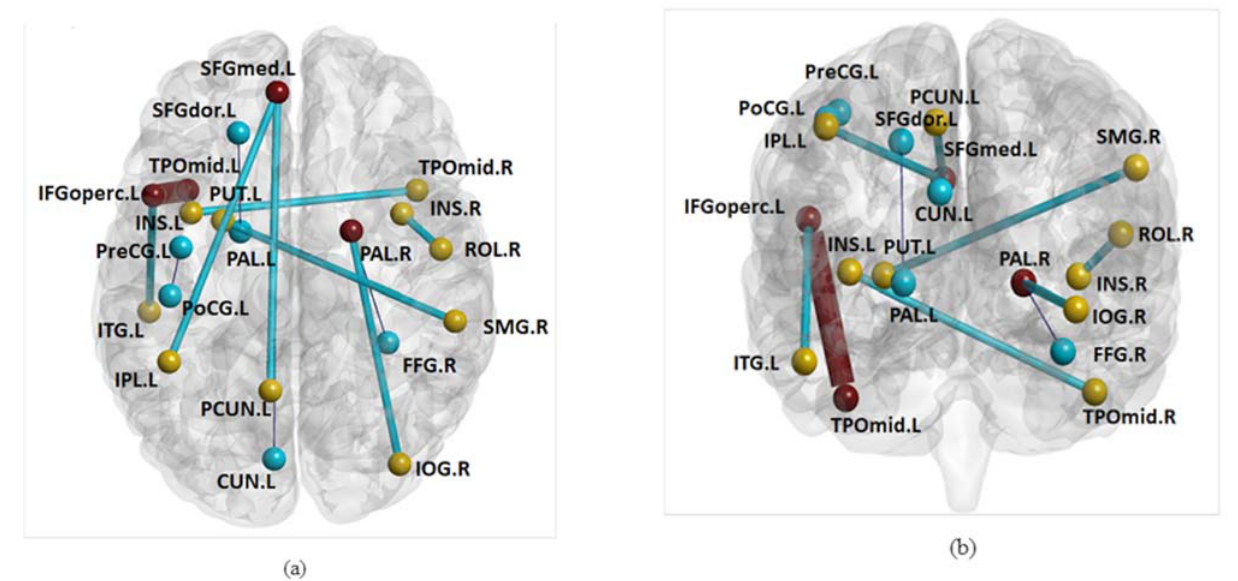
Figure 4. Selected features (i.e., functional network edges) that have been employed to build final models. Selected features are mapped onto automated anatomical labelling (AAL) atlas in: ( a ) axial view and ( b ) coronal view. Note: Blue and yellow nodes are involved in LOFC and HOFC, respectively, whereas the brown node (e.g., SFGmed.L) is involved in both LOFC and HOFC; network edges identified as features are classified into 3 categories: (1) An edge is identified as a feature from LOFC only (black thin edges); (2) An edge is identified as a feature from HOFC only (blue edges); (3) An edge is identified as a feature from both LOFC and HOFC (brown thick edges). LOFC = low-order functional connectivity. HOFC = high-order functional connectivity. Names and corresponding abbreviations of the brain regions are presented in the Appendix A.